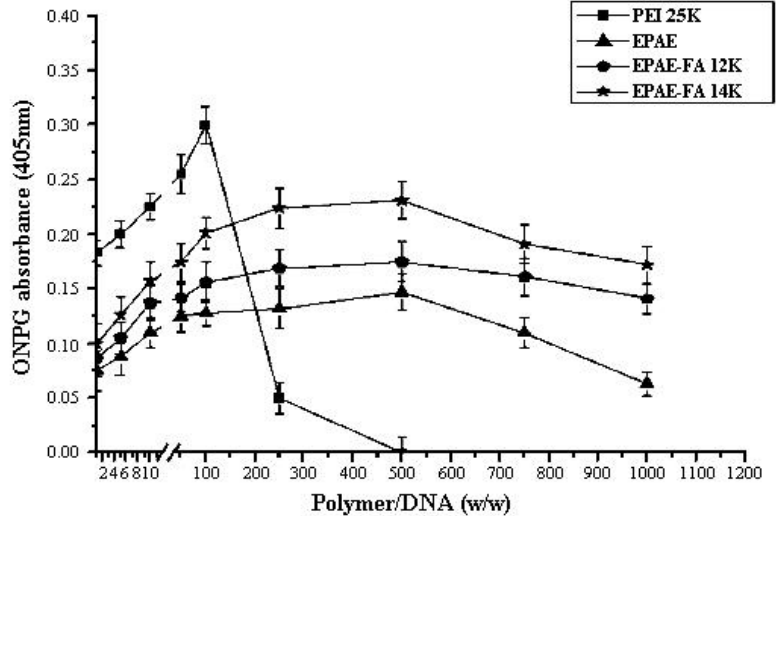
Figure 10. Transfection efficiency of the polymer/DNA complexes into cultured COS-7 cells. Results are presented as the mean ± SD (n =